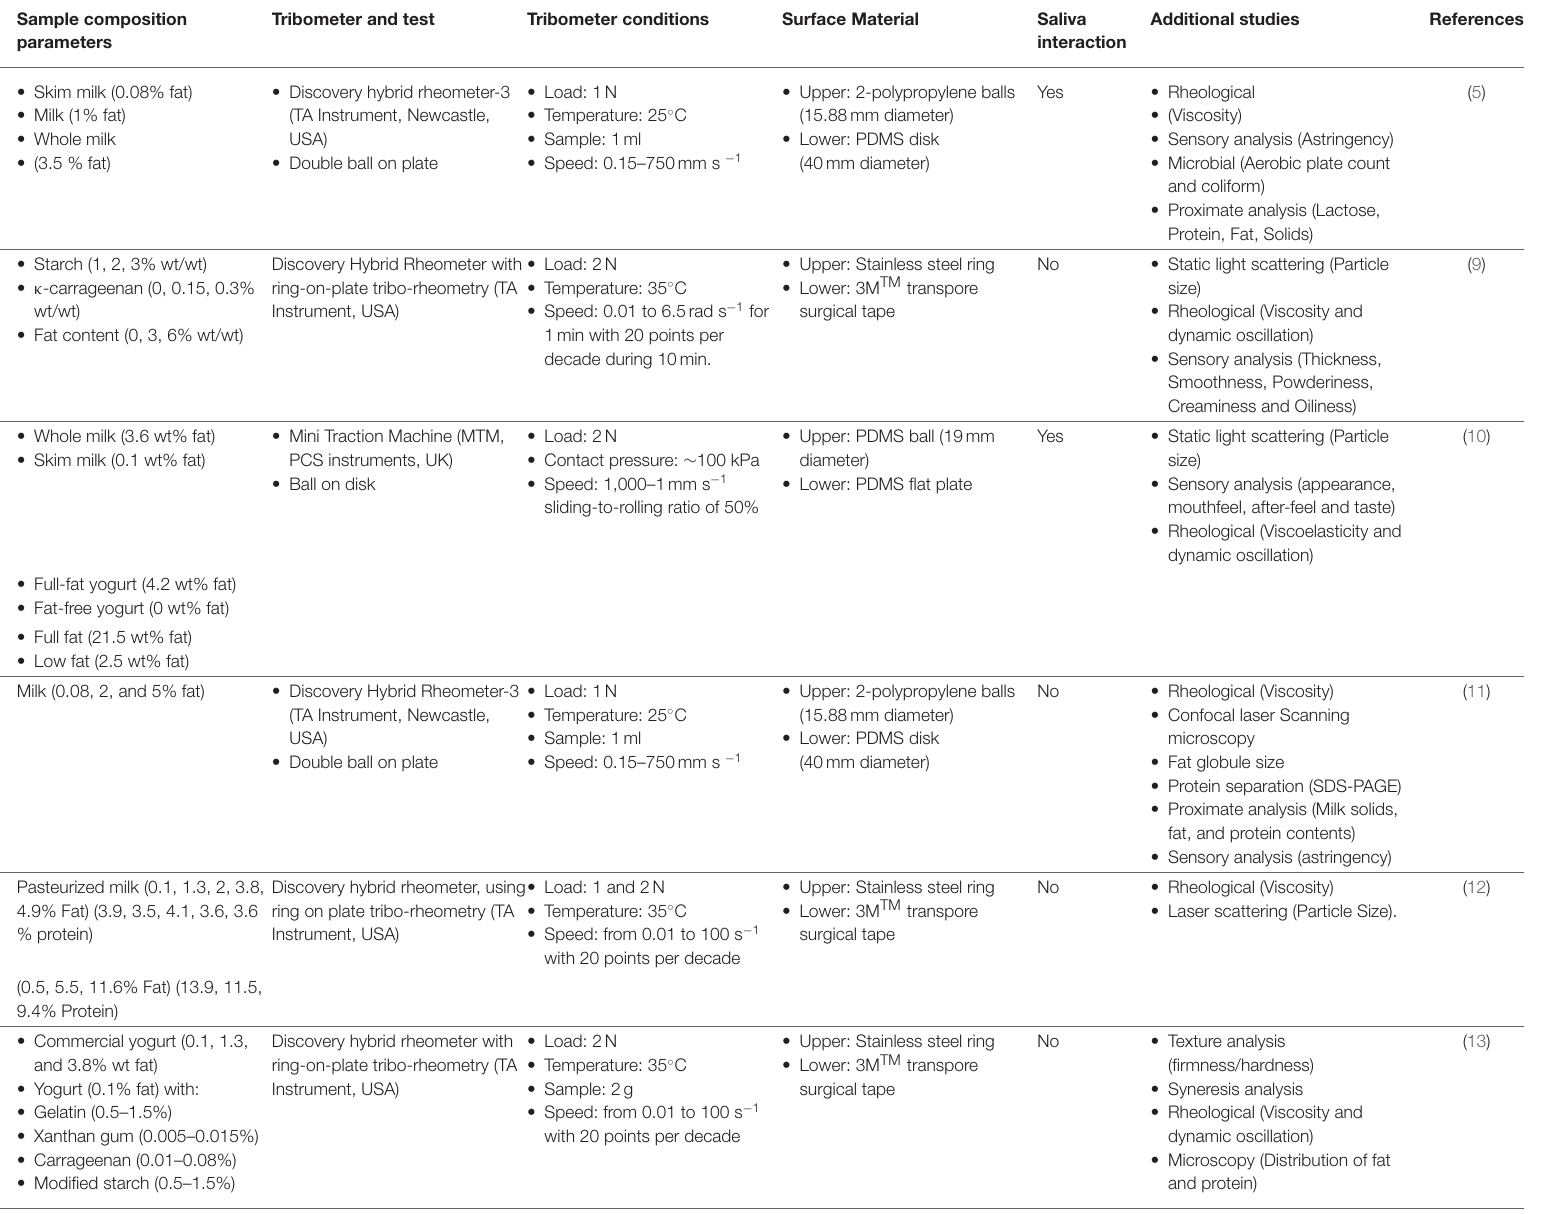
TABLE 1 | Summary of tribological studies on dairy